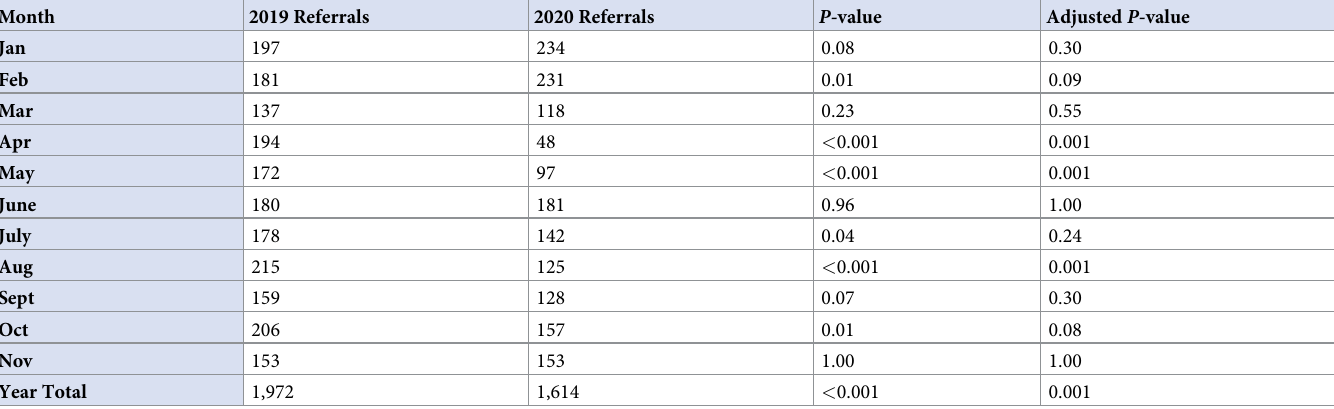
Table 2. Referral data in 2019 and 2020 by